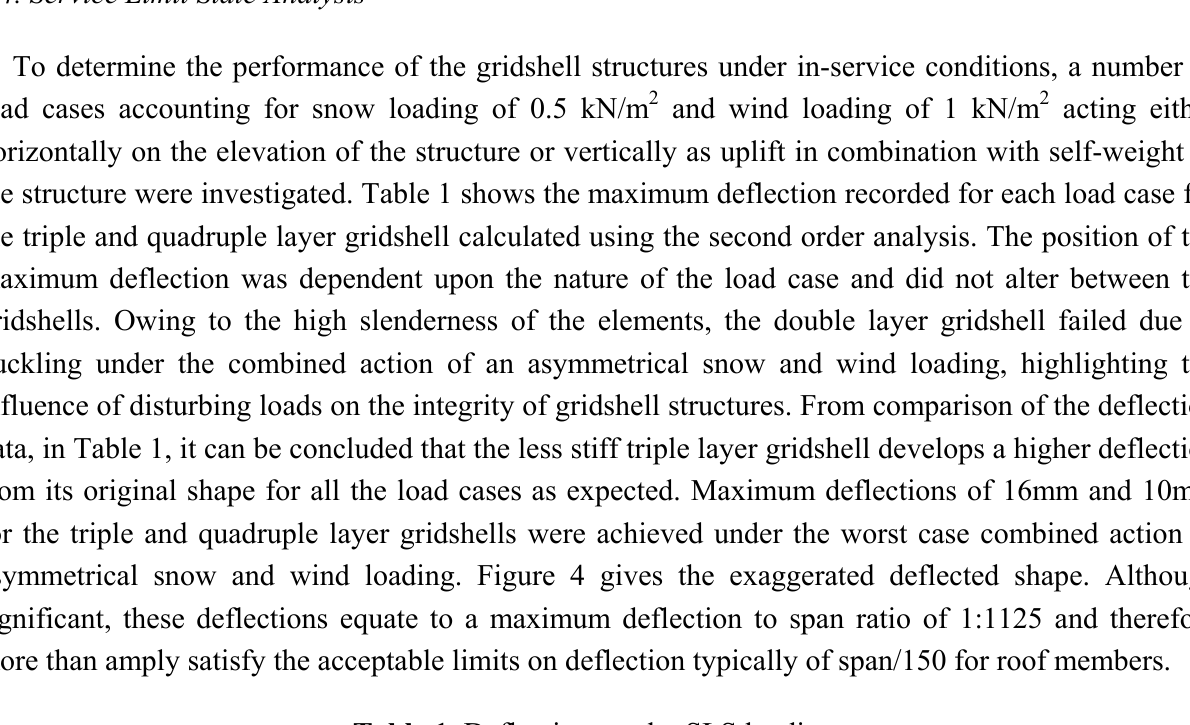
Table 1. Deflections under SLS